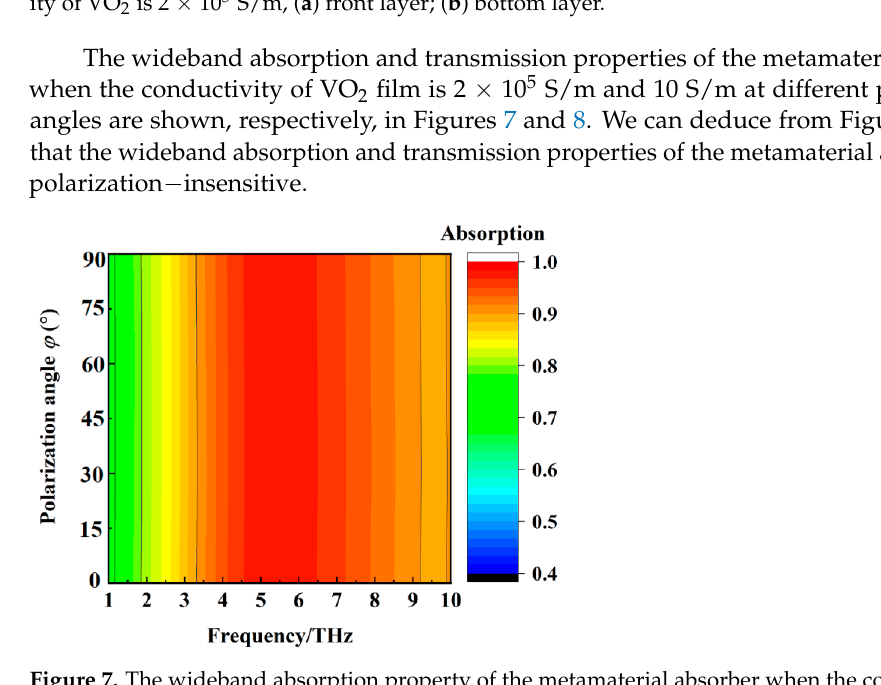
Figure 7. The wideband absorption property of the metamaterial absorber when the conductivity of VO 2 film is 2 × 10 5 S/m at different polarization angles.